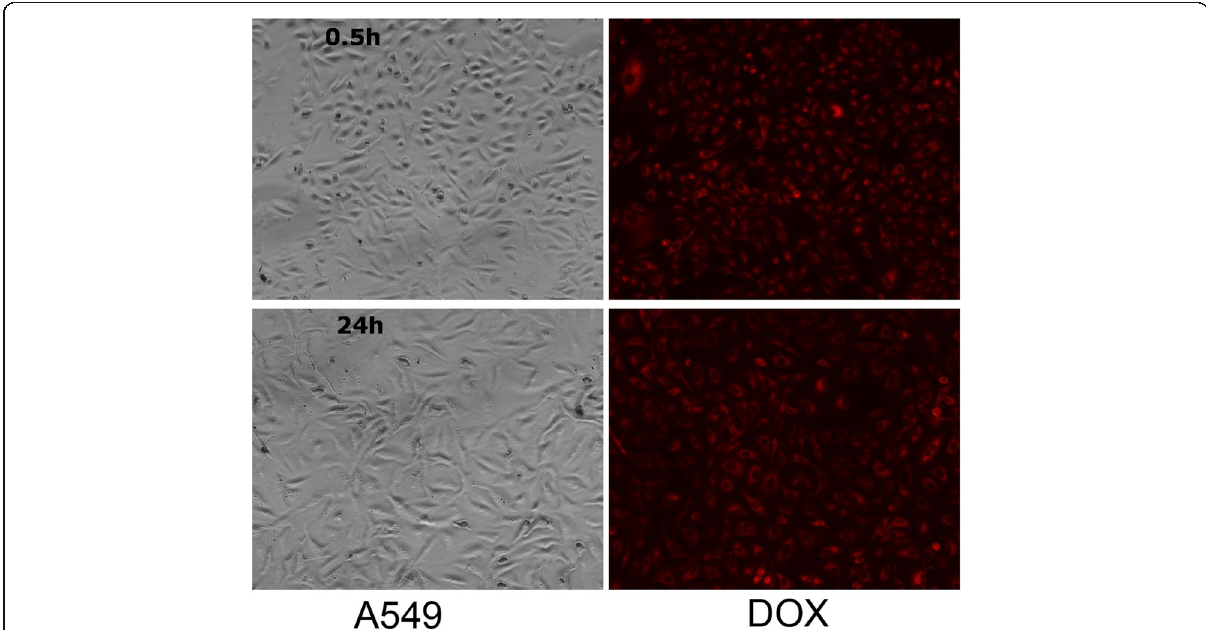
Fig. 6 Confocal fluorescence microscopic images of A549 cells incubated with the Fe 3 O 4 NC/PAH/PSS/DOX hybrid nanostructures at 37 °C for a 0.5 h and b 24 h. Scale bar, 20 μ